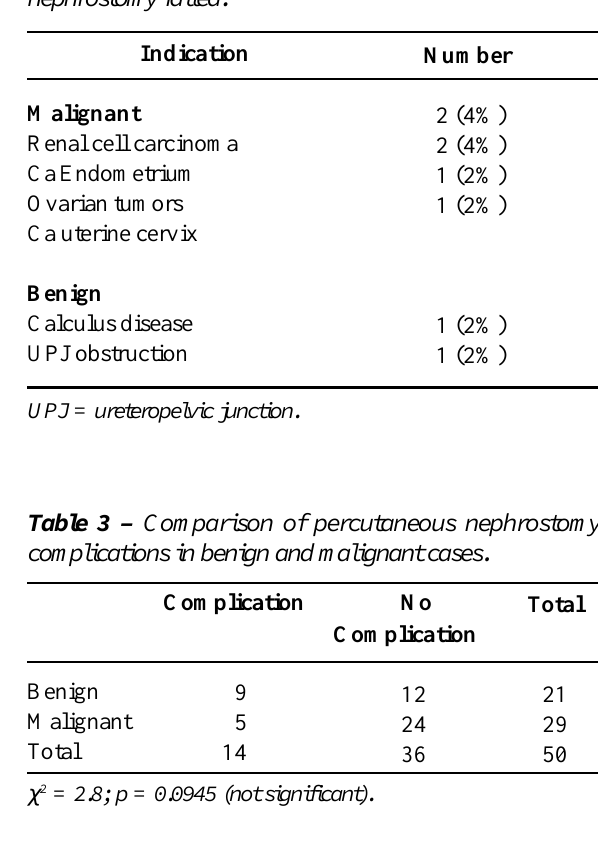
Table 2 – Distribution of cases in which percutaneous nephrostomy failed.